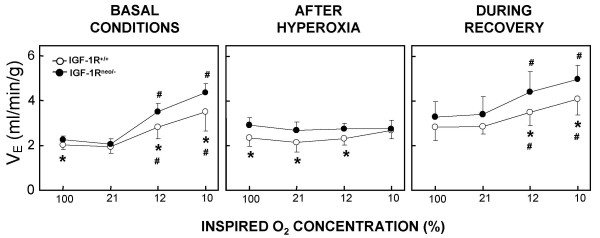
Ventilatory responses before and after hyperoxia, and during recovery. Minute ventilation (VE) in response to decreasing levels of inspired O2. In each one of the three conditions, mean values (± SD) of VE in IGF-1R+/+ and IGF-1Rneo/- mice were recorded under 90% O2, 21% O2 and at two levels of hypoxia (12% and 10% O2). Values with asterisks are significantly different from control values at 90% O2. Crosses indicate significant differences from normoxic control values, and asterisks indicate significant differences between IGF-1R+/+ and IGF-1Rneo/- mice; P < 0.05.